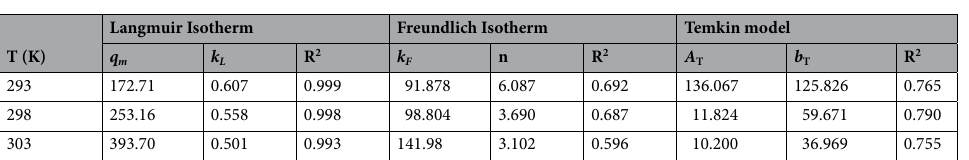
Table 3. The adsorption isotherm parameters of the adsorption of uranyl ions by ZnNiAl-LDHs. The units of